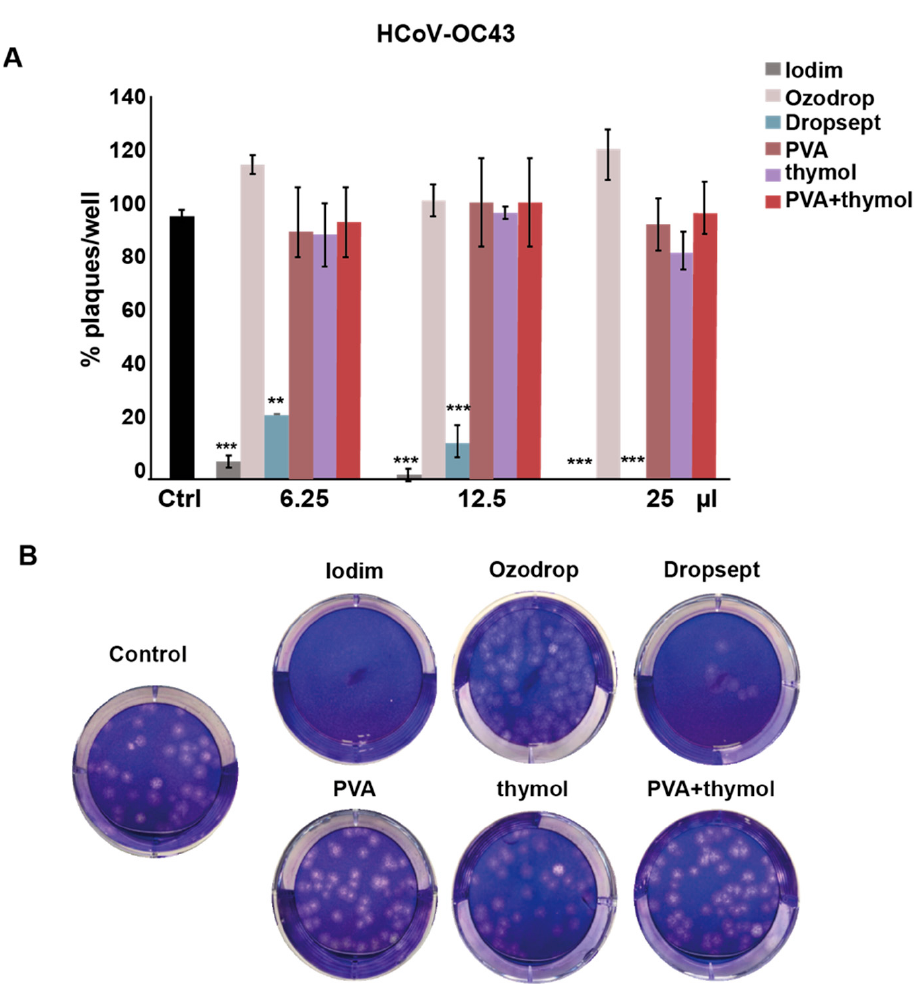
Figure 4. Antiviral activity of the ophthalmic formulations against HCoV-OC43 . ( A ) Histograms of the number of plaques for each test solution at different volumes. The indicated ophthalmic solutions were incubated simultaneously with the virus on A549 cells at different volumes, and the plaques monitored after 5 days of incubation. The results are presented as mean ± SD. t -test ** p < 0.01, *** p < 0.001 vs. Ctrl. ( B ) Representative pictures of A549 cells incubated with HCoV-OC43 w/wo formulations (12.5 μ L) and stained with crystal violet.